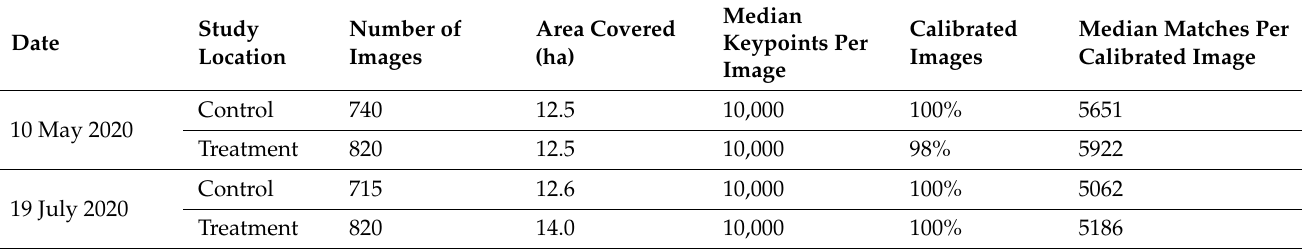
Table 5. Summary of images processed, area covered, median keypoints per image, calibrated images, and median matches per image for sUAS multispectral orthomosaic.